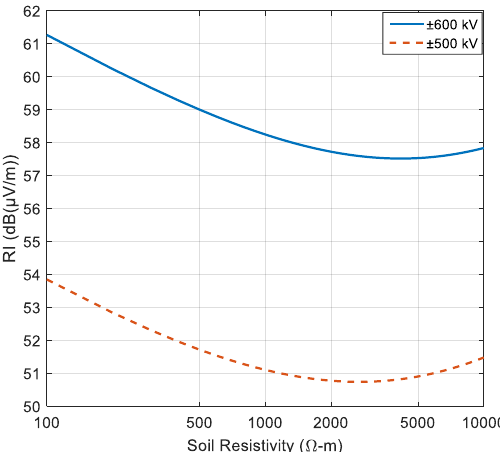
Figure 8. RI as a function of the soil resistivity.